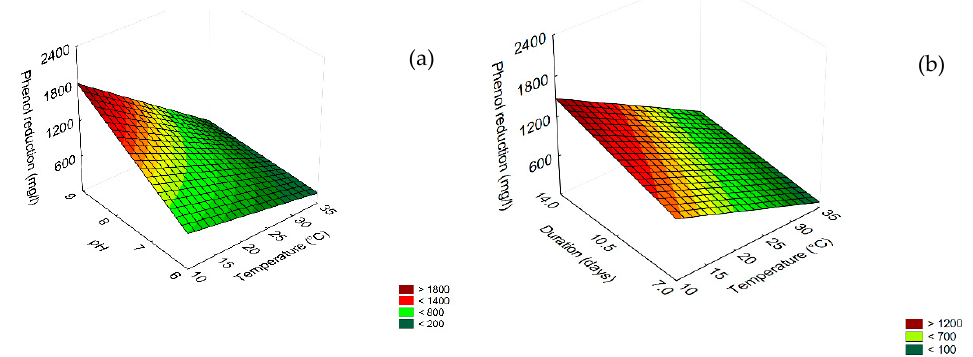
Figure 2. Surface response plots for the interaction pH / temperature ( a ), duration / temperature ( b ) on phenol reduction by the combination of B. pumilus – C. boidinii strains.